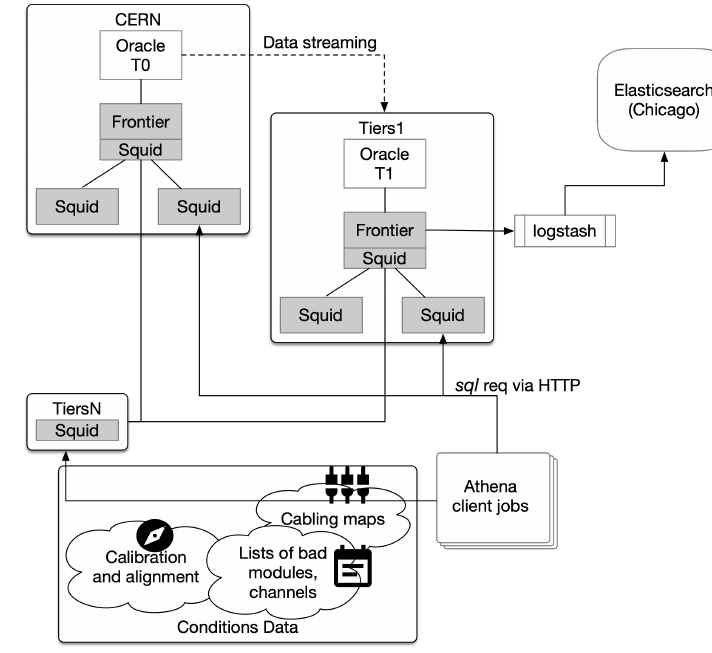
Figure 1. ATLAS distributed architecture for the Conditions data